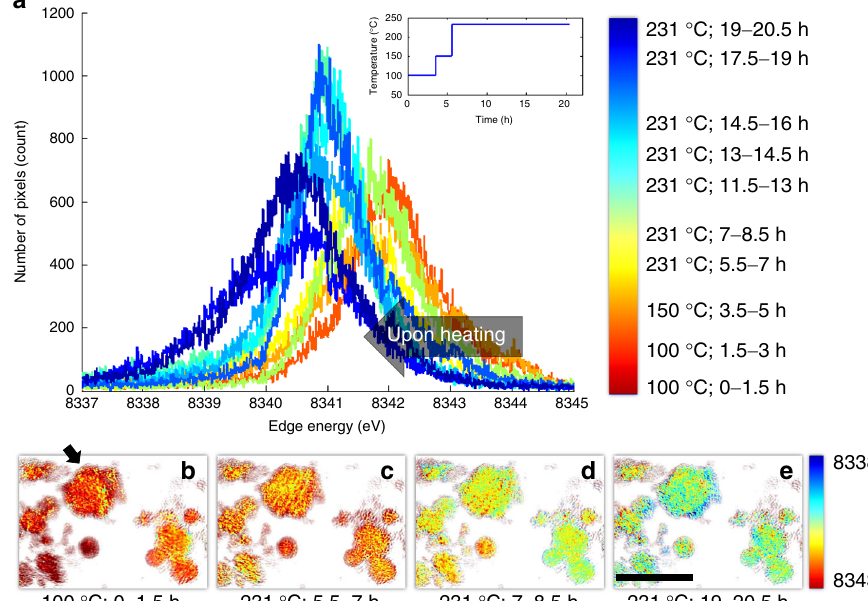
Fig. 1 Direct visualization of the changing Ni valence state in Li 0.4 Ni 0.4 Mn 0.4 Co 0.2 O 2 polycrystalline ensembles upon in situ heating. a The histogram of the local valence states of Ni (represented by the Ni K-edge X-ray absorption spectroscopy (XAS) absorption edge) over the entire fi eld of view, with the heating pattern shown in the inset. b – e The maps of the Ni valence states observed in situ, which are color coded to the local Ni valence state as indicated by the color map to the right of ( e ). The Ni valence states are represented by the Ni K-edge XAS absorption edge, where a higher energy and a lower edge energy represent a higher and a lower Ni valence states,